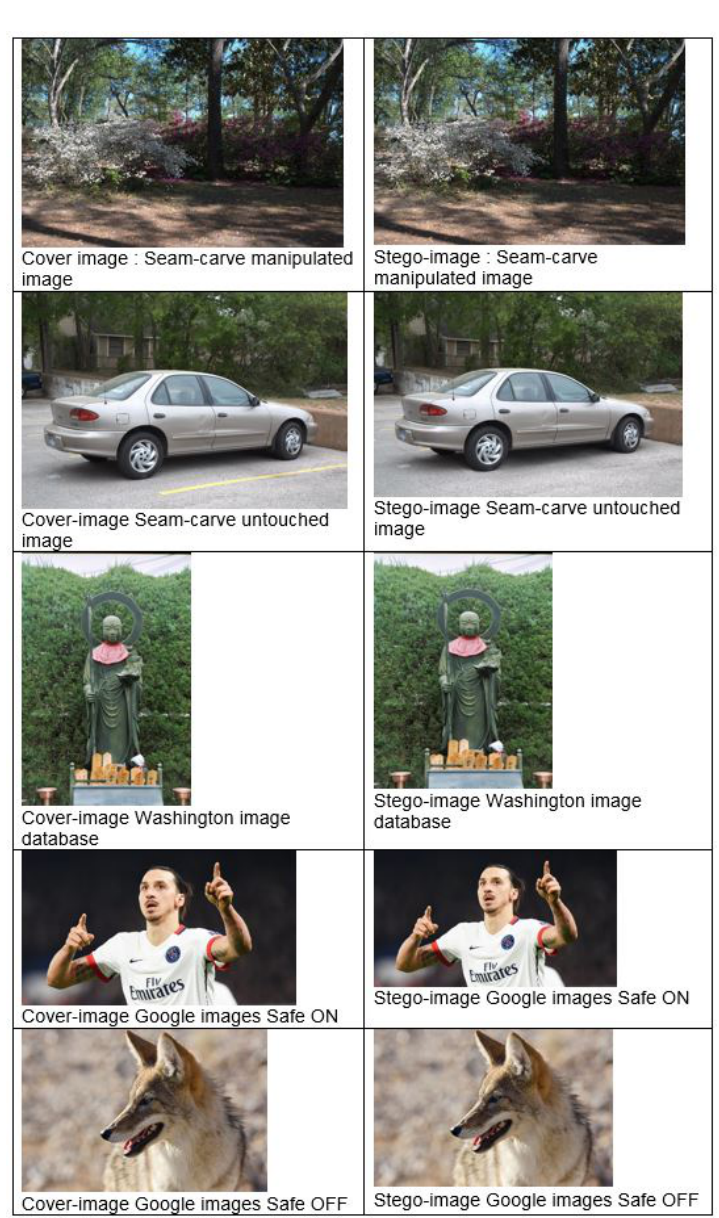
Figure 1. Sample results of the jphide